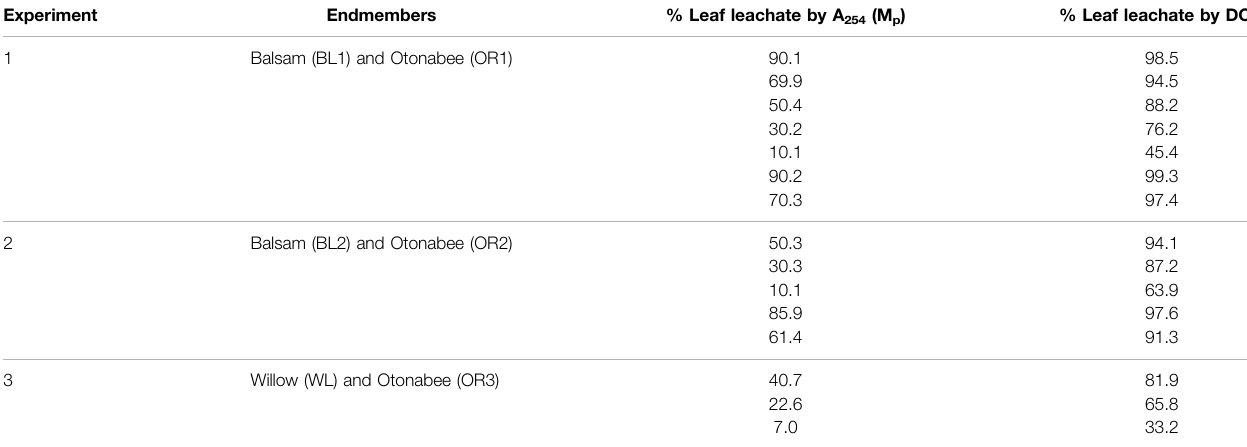
TABLE 1 | Endmember contributions to DOC and absorbance at the fractogram peak maximum of mixtures.